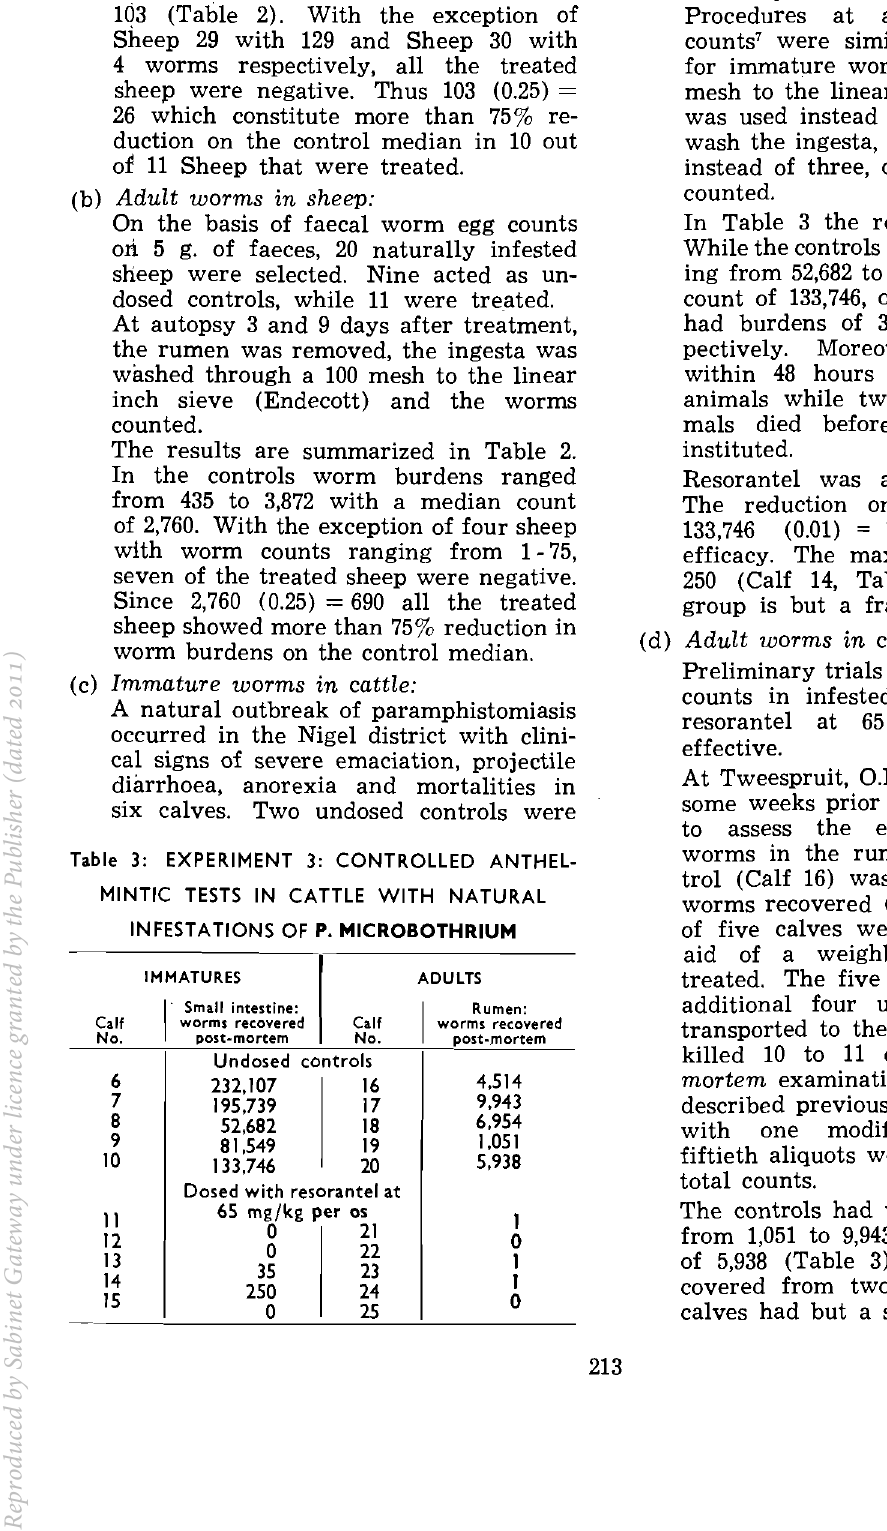
Table 3: EXPERIMENT 3: CONTROLLED ANTHEL MINTIC TESTS IN CATTLE WITH NATURAL INFESTATIONS OF P.